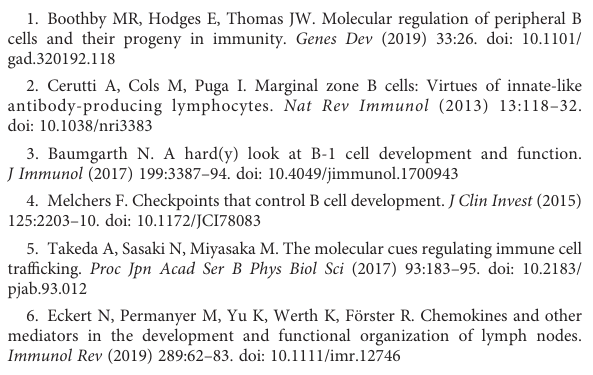
SUPPLEMENTARY FIGURE 6 Expression of FOXO1 and HSP90 in magnetically-puri fi ed control and